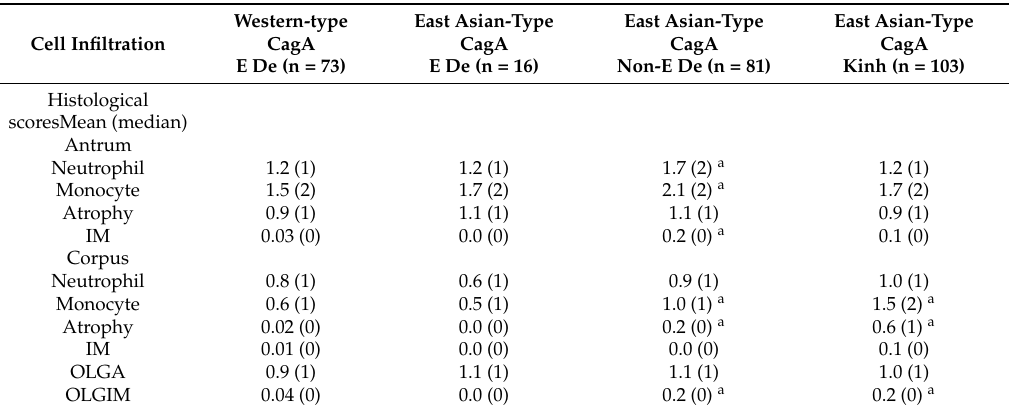
Table 5. Comparison of histological scores between Western-type CagA and East–Asian-type CagA strains of different ethnic